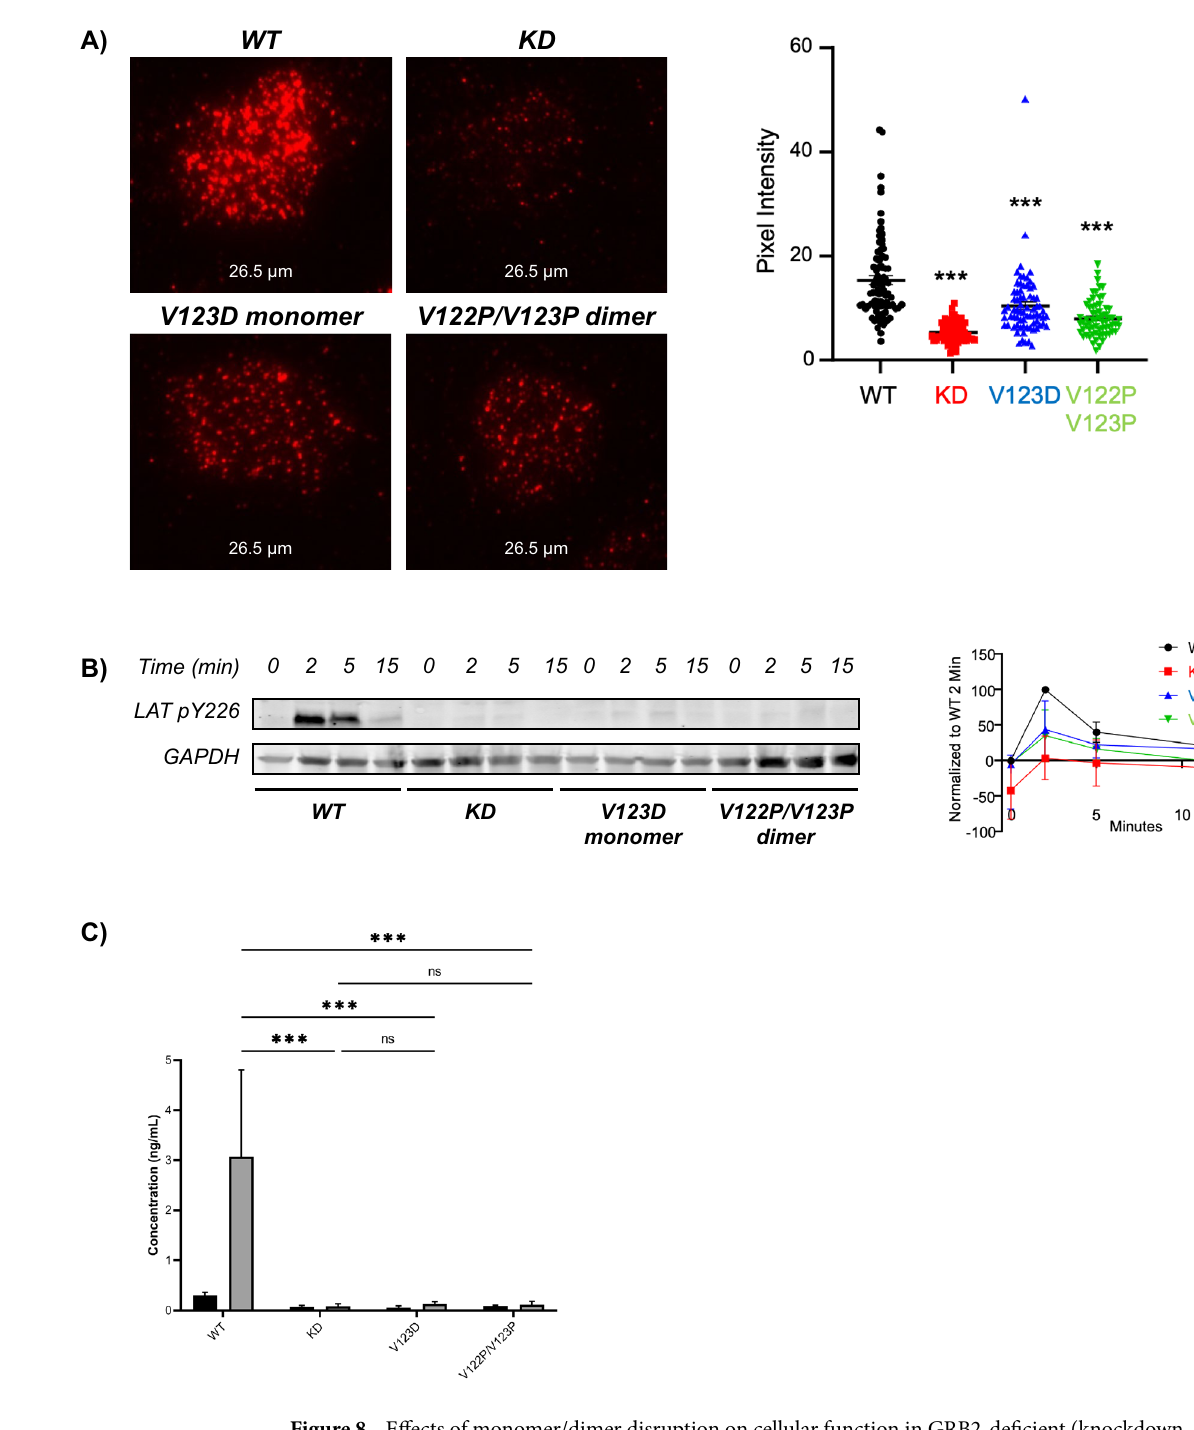
Figure 8. Effects of monomer/dimer disruption on cellular function in GRB2-deficient (knockdown, or KD) and mutant GRB2-expressing T cells. ( A ) Phosphorylated LAT clustering at the plasma membrane was analyzed by TIRF microscopy (N = 3 with 50 + analyzed cells) and quantified. ( B ) LAT phosphorylation over time was analyzed in response to stimulation with 1 μg/mL anti-CD3 antibody, using Western blot and densitometric quantification (N = 2–3). ( C ) Secretion of IL-2 in response to stimulation with 1 μg/mL anti-CD3 antibody for 24 h was analyzed by ELISA (N = 3). Two-way ANOVA analysis was used to determine significance, denoted by ** as P < 0.01 and *** as P <